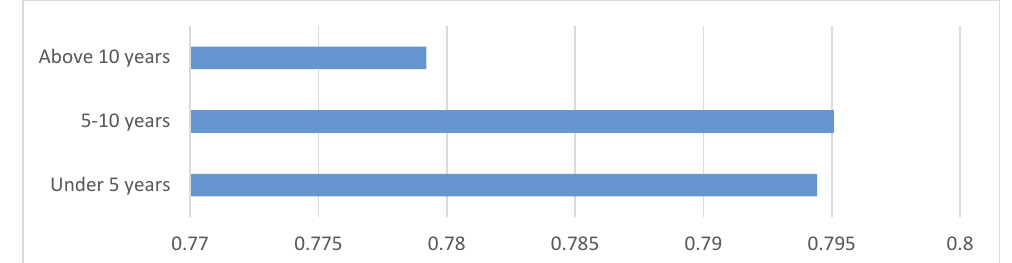
Fig. 4. Efficiency score by the number of years of